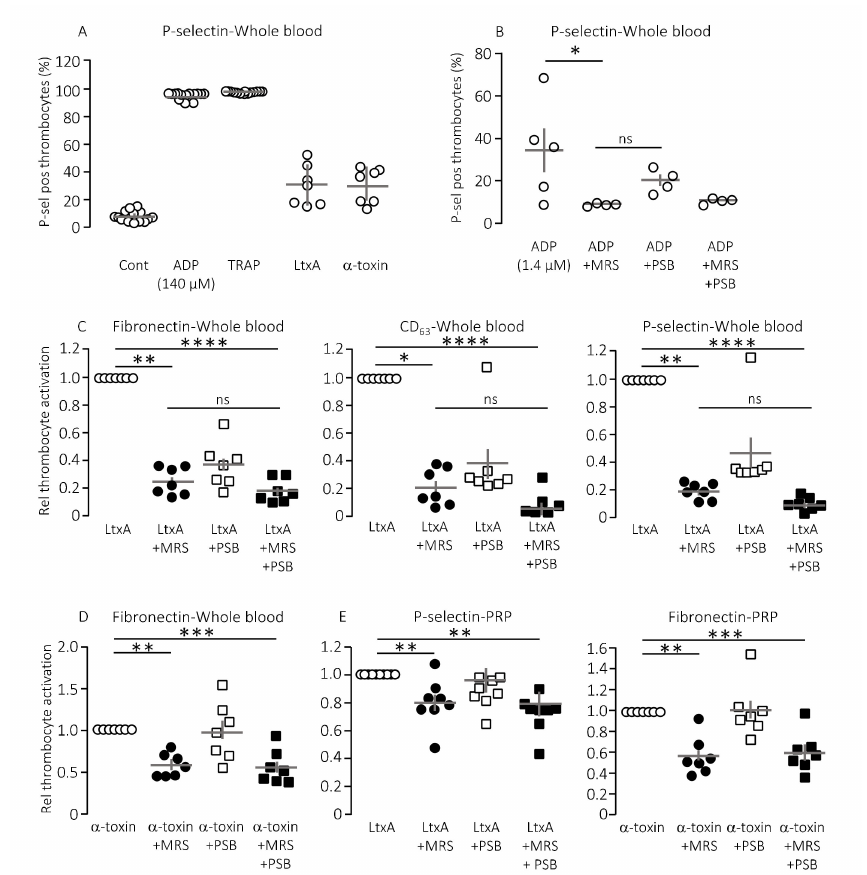
Figure 1. The effect of P2Y receptor blockade on the thrombocyte activation induced by pore-forming toxins in vitro. Thrombocyte activation is measured as the P-selectin, fibronectin and CD63 positive cells as a percentage of the total number of thrombocytes. ( A ) The pore-forming toxin α -toxin ( n = 7) and leukotoxin A (LtxA, 30 µ g mL − 1 , n = 7) readily activates thrombocytes here shown as the relative number of P-selectin positive thrombocytes. Activation of thrombocytes with adenosine diphosphate (ADP, 140 µ M, n = 14) and thrombocyte activating peptide (TRAP, 371 µ M, n = 14) was used as positive controls and a HEPES-buffered solution was used as negative control (Cont). The addition of pore-forming toxin was adjusted to give a thrombocyte activation of approximately 25%. ( B ) The effect of P2Y 1 and P2Y 12 receptor inhibition on the ADP-induced thrombocyte activation. MRS2500 (MRS) was used in a concentration of 9 µ M and PSB0739 (PSB) 18 µ M. ( C ) The effect of MRS2500 9 µ M ( n = 7) and PSB0739 18 µ M ( n = 7) on the thrombocyte activation induced by LtxA in whole blood measured as fibronectin, CD63 and P-selectin positive thrombocytes. For the combined effect of MRS2500 and PSB0739 n = 7. ( D ) The effect of MRS2500 9 µ M ( n = 7) and PSB0739 18 µ M ( n = 7) on α -toxin-induced thrombocyte activation in whole blood. For the combined effect of MRS2500 and PSB0739( n = 7). ( E ) The effect of MRS2500 9 µ M ( n = 8) and PSB0739 18 µ M ( n = 8) on LtxA-induced or α -toxin-induced thrombocyte activation in platelet enriched plasma (PRP). For the combined effect of MRS2500 and PSB0739 n = 8. All data are given as single observations and mean ± S.E.M.* p < 0.05, ** p < 0.01, *** p < 0.001 and **** p <